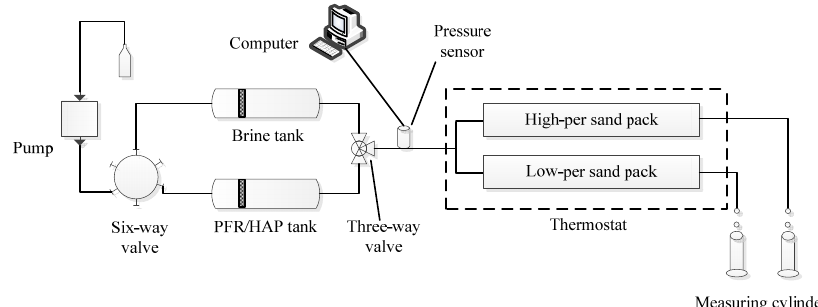
Figure 4. Schematic diagram of oil displacement experiment for parallel sand packs.